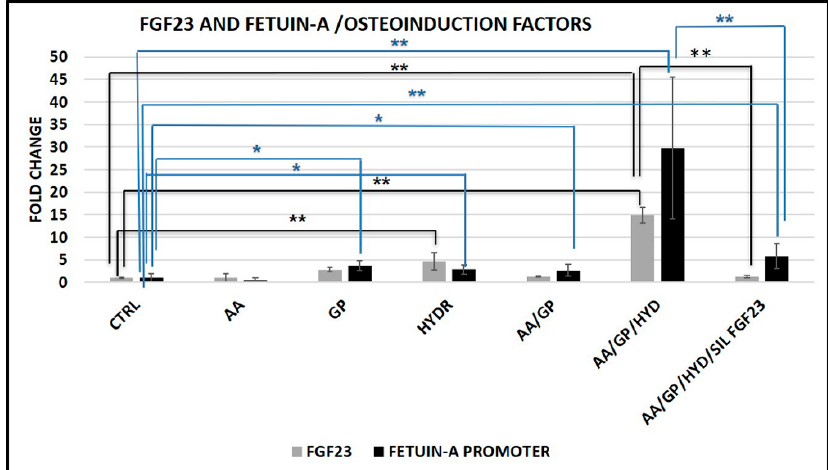
Figure 13. qRT-PCR of FGF23 and Fetuin-A promoter 5 days after AA, GP, HYD, AA/GP, and AA/GP+ HYD addition. The last condition represented all conditions added with FGF23 silencing for 24 h. * p < 0.05, ** p < 0.01.